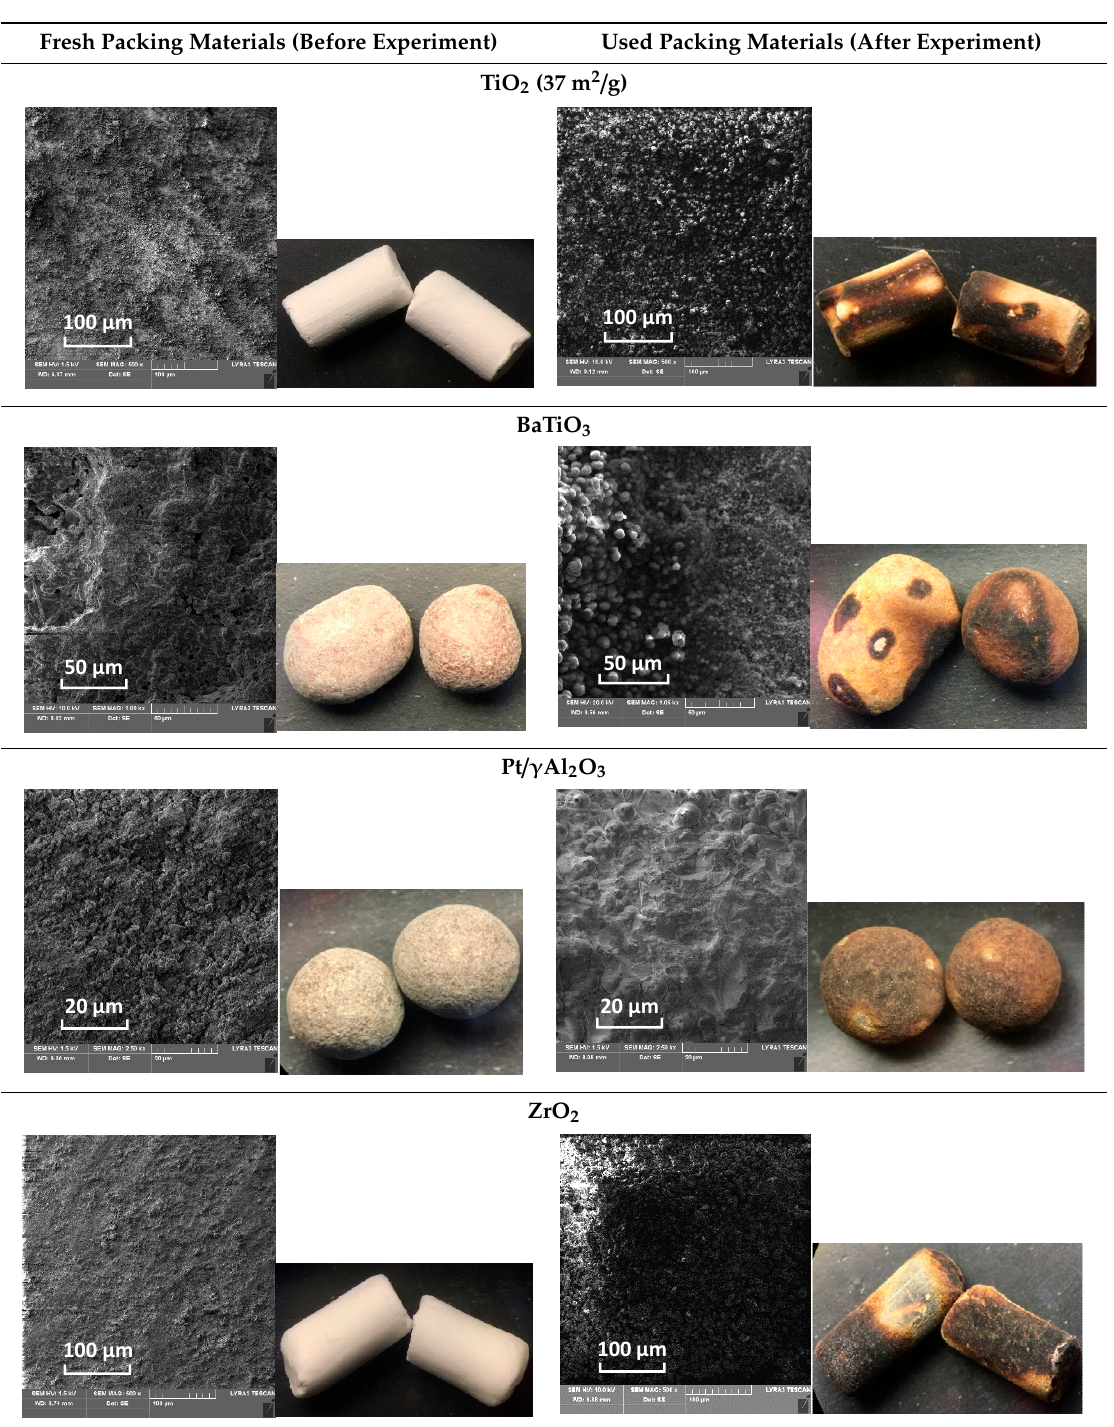
Table 1. Cont. Fresh Packing Materials (Before Experiment) Used Packing Materials (After